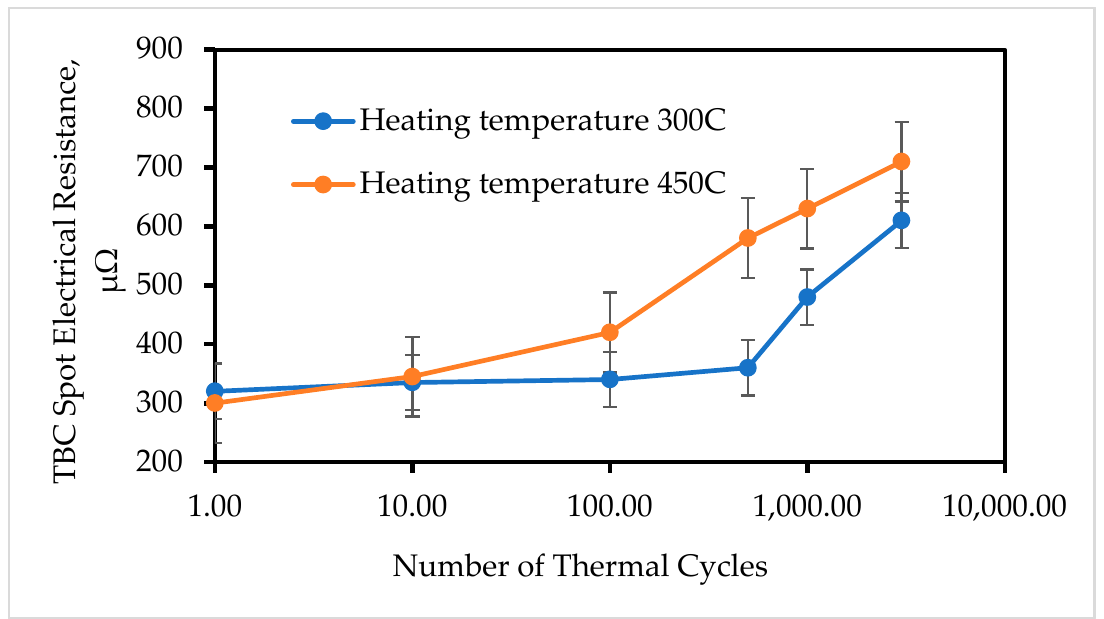
Figure 18. Electrical resistance of SHS717-Al multilayer TBC (coating #2, Table 1). The formation of intermetallics is shown on SEM images of microstructure (Figure 19a) and fracture topography (Figure 19b). Only a small portion of the Fe phase (bright at Figure 19, spot #1, Table 5) can be seen in the SHS717 particles. The main volume of these particles is transformed to intermetallics (grey phase).